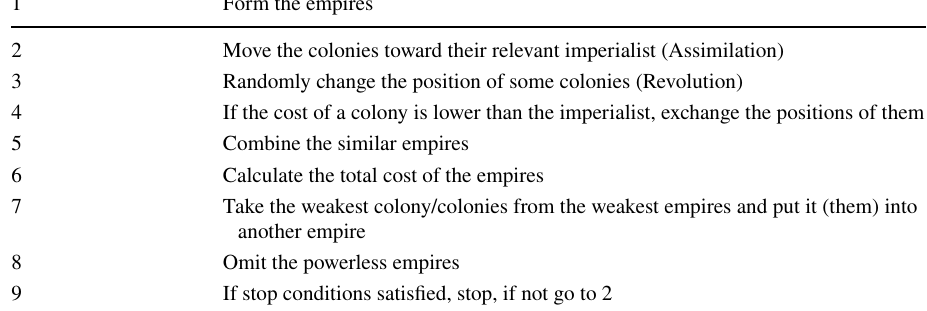
Table 2 Pseudo code for the